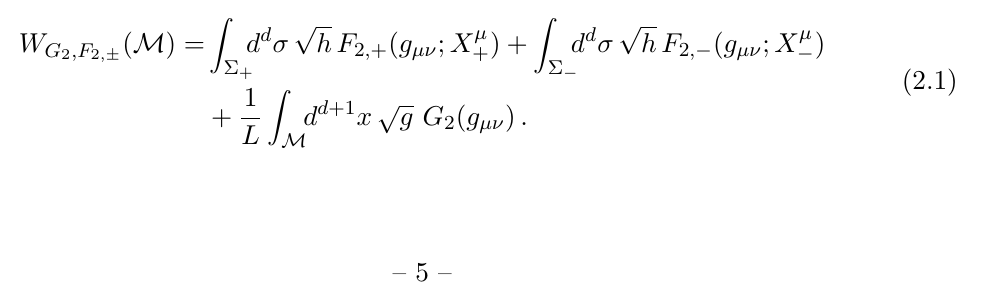
, respectively, and ± CFT